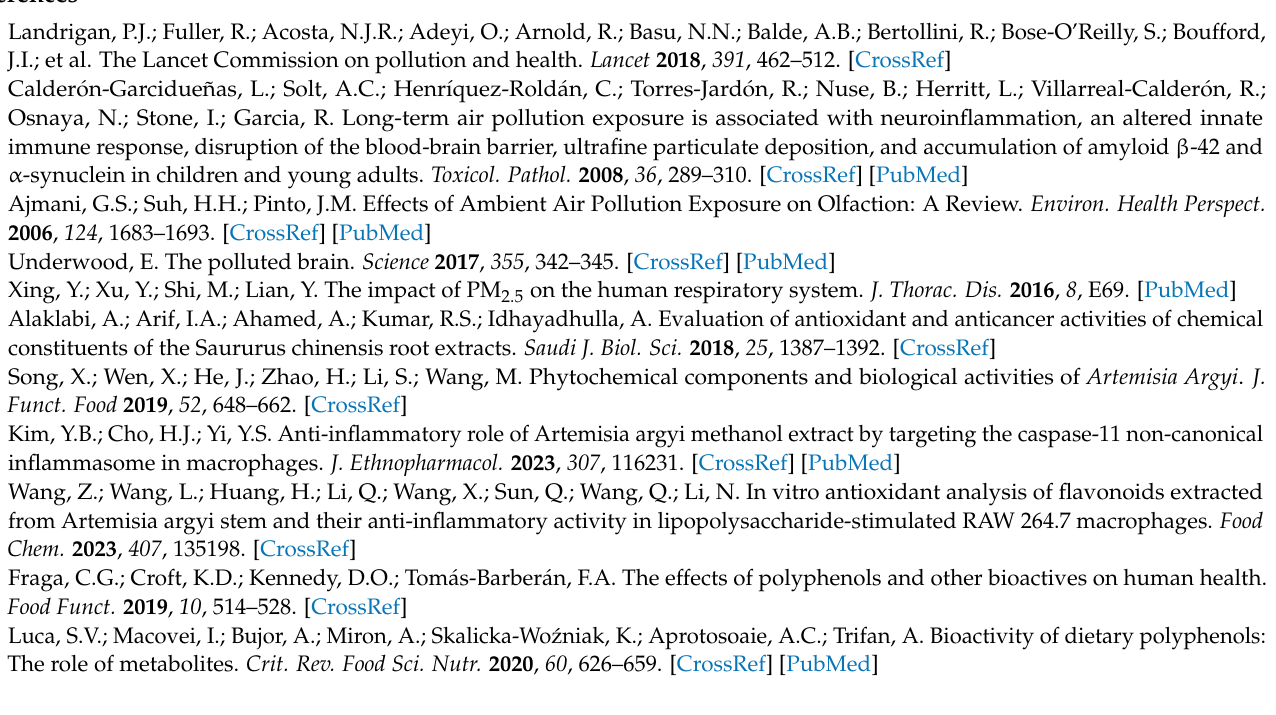
Figure S3: Analysis of Artemisia argyi, Saururus chinensis , AASC and Blank using UPLC/Q-TOF- MS/MS chromatography in negative ion mode. Table S1: List of antibodies and their information used in this